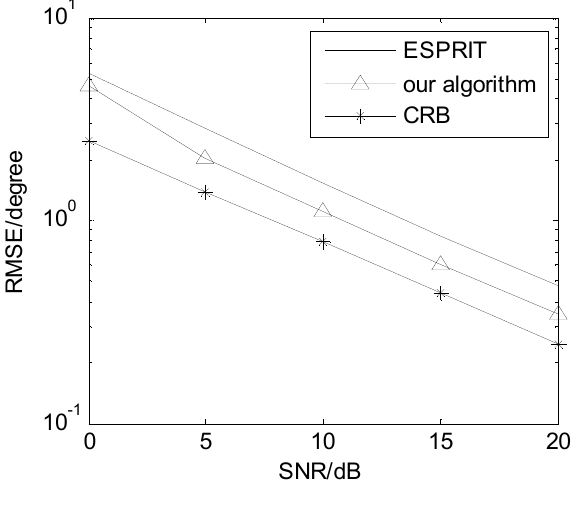
Figure 11. Angle estimation performance comparison for non-coherent